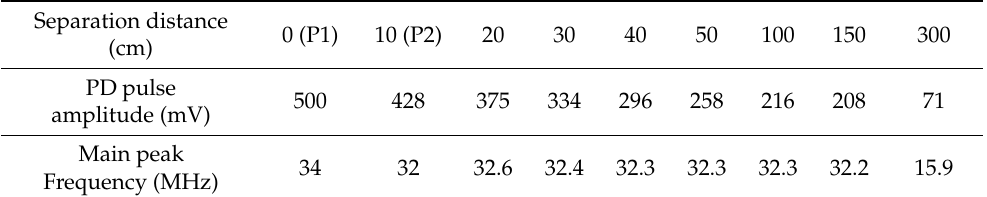
same. Table 4. PD pulse amplitude and peak frequency detected by the non-spiral sensor as a function of distance from the